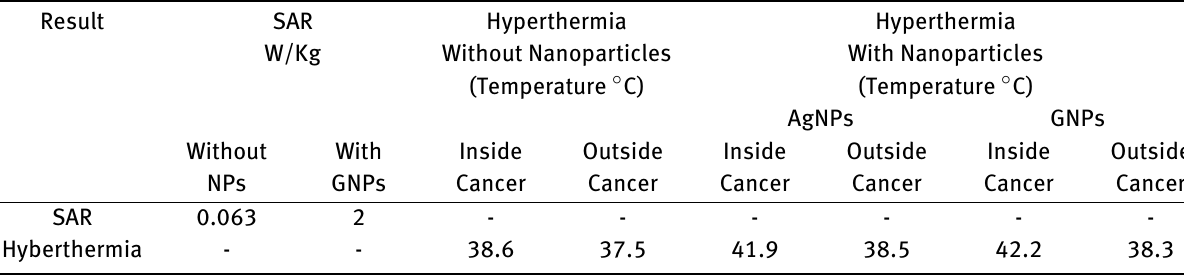
Table 5: SAR and Hyperthermia Results at 915 MHz Result